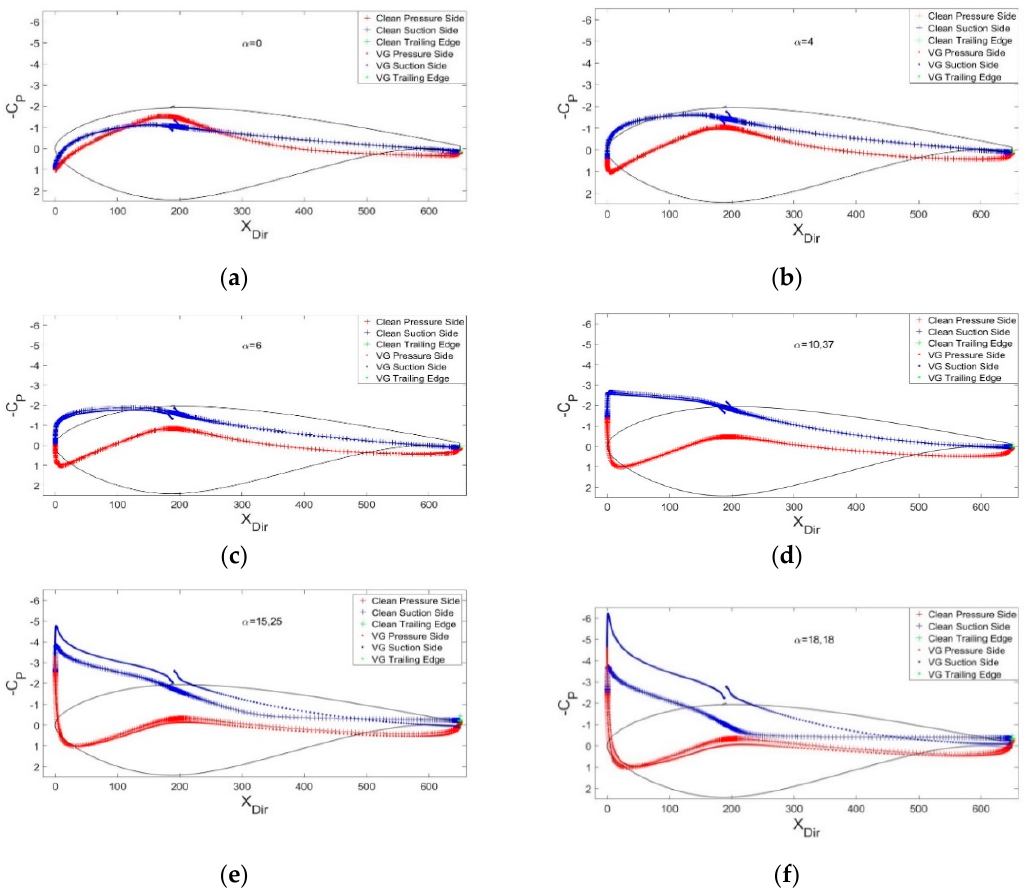
Figure 11. Comparison for DU97W300 and Re = 2 × 10 6 data of pressure coefficient at ( a ) 0°, ( b ) 4°, ( c ) 6°, ( d ) 10.37°, ( e ) 15.25°, and ( f ) 18.18° AoA.